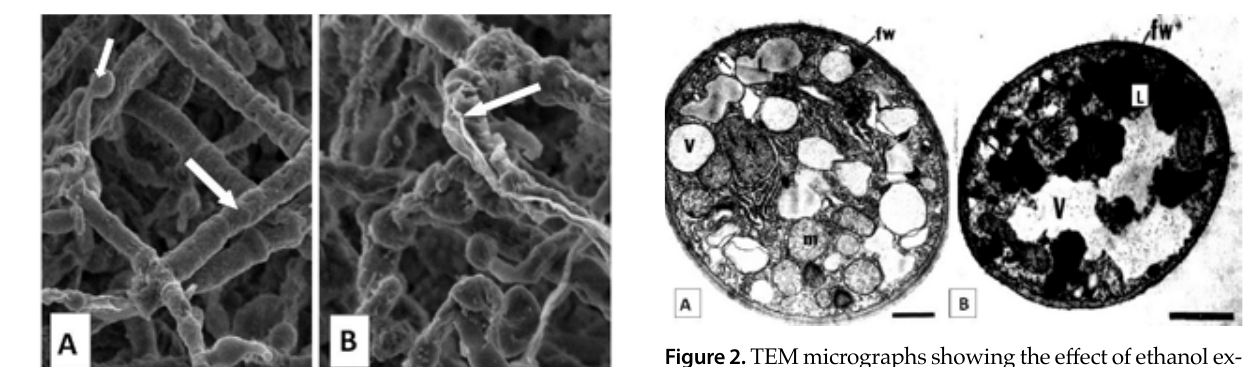
Figure 2. TEM micrographs showing the effect of ethanol ex - tract of Calotropis procera on the ultrastructure of Alternaria solani hyphae. (a) A section of a hypha from untreated medi- um (control) showing an electron-opaque hyphal wall (fw) adjacent to the plasmalemma (arrow). Note the nucleus (N), numerous lipid bodies (L), Golgi bodies (g), endoplasmic reticulum (er), mitochondria (m) and numerous vacuoles (V). Bar = 0.5 μm. (b) A section of a hypha from medium amended with 20 % plant extract. Note the hyphal wall (fw), large electron-dense lipid bodies (L), large vacuoles (V). Note also the electron-dense material (arrowheads) de- posited on the plasmalemma (arrow). Bar = 1.0